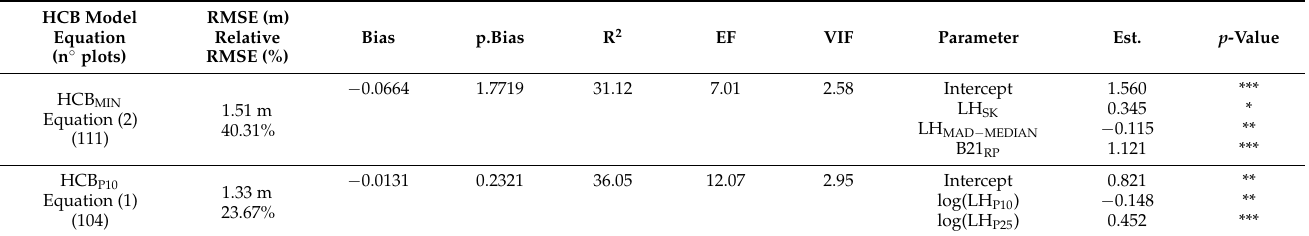
Figure 2. Workflow of the methodology steps. Green dot—estimates made at plot level; blue star—estimated and measured HCB filters; orange star—LiDAR metrics calculated with the complete point cloud and used in the HCB estimated filters modelling; green star—LiDAR metrics, calculated on the filtered point cloud, used to evaluate UH; purple star: LiDAR metrics, calculated on the filtered point cloud, used to assess the UC. Table 2. The goodness of fit parameters and regression coefficients for predicting